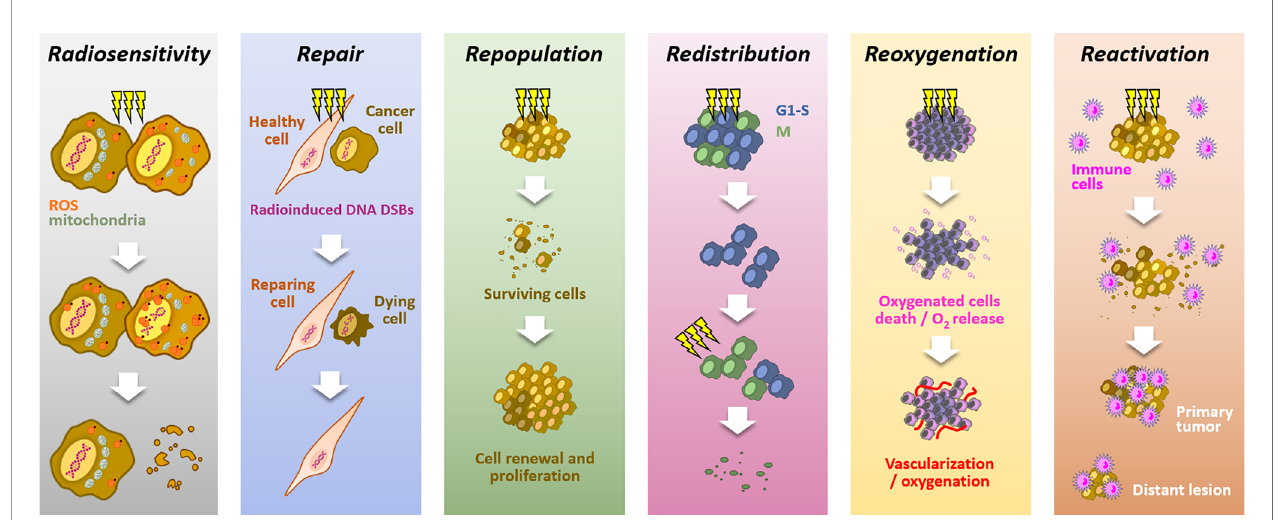
FIGURE 1 | The six “ Rs ” dictating the response to radiotherapy. Radiotherapy response depends on six parameters: Radiosensitivity , refers to the cell-intrinsic mechanisms ( e.g. , metabolic adaption, ROS detoxi fi cation), explaining differences in cell responses to irradiations; Repair , refers to the cell capacity to survive by repairing radio-induced damages (particularly DSBs), in theory, more characteristic of healthy cells; Repopulation , refers to the tumor cells capacity to grow following a radiotherapy fraction; Redistribution , refers to the progression of cancer cells from radioresistant cell cycle phases ( i.e. , G1/S) toward more radiosensitive phases ( i.e. , G2/M), between radiotherapy fractions; Reoxygenation , refers to the oxygen level recovery following irradiation, due to well-oxygenated cells death and tumor vascularization; Reactivation , refers to the triggering of a systemic anti-tumor immune response following irradiation-induced immunogenic cell